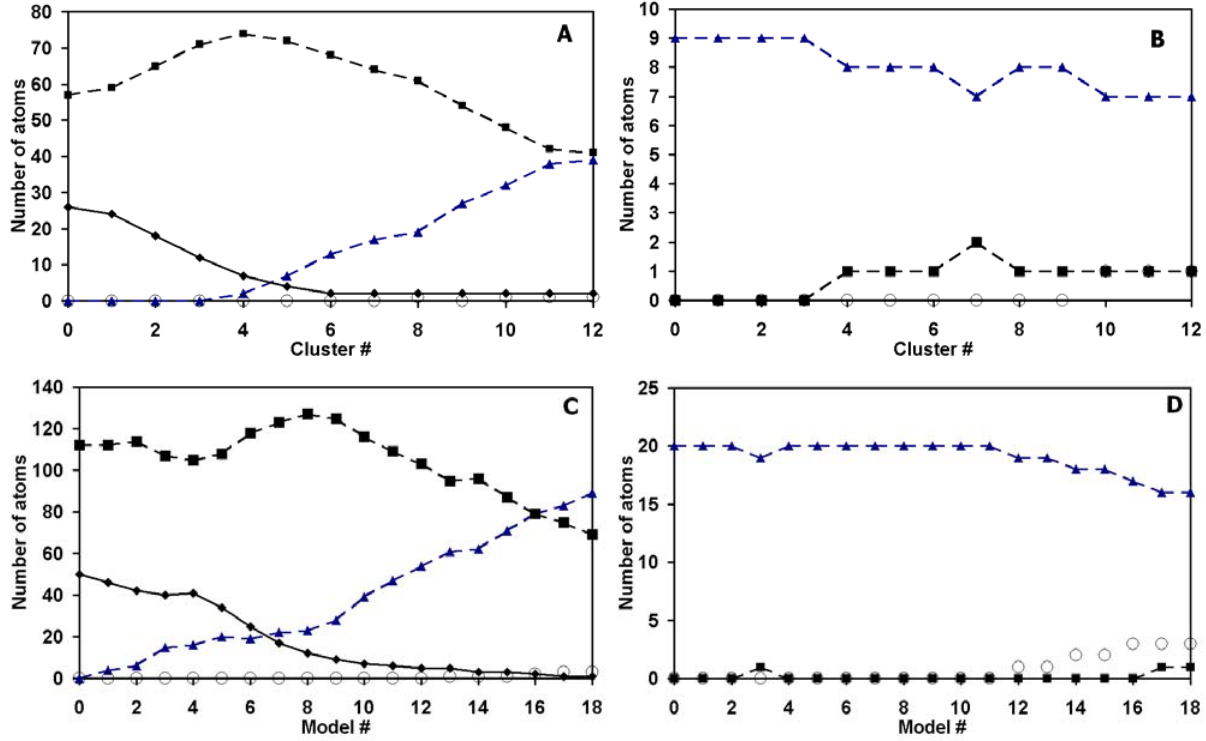
Figure 5. Change of the QC evaluated coordination number distribution for (a) carbon, (b) nitrogen atoms in the PVPDVB cluster and (c) carbon and (d) nitrogen atoms in the PVPDVB periodic model upon carbonisation. Solid line and rhombs – number of 4-fold coordinated atoms, dashed line and squares – number of 3-fold coordinated atoms, dashed line and triangles – number of 2-fold coordinated carbon atoms, circles – number of 1-fold coordinated carbon